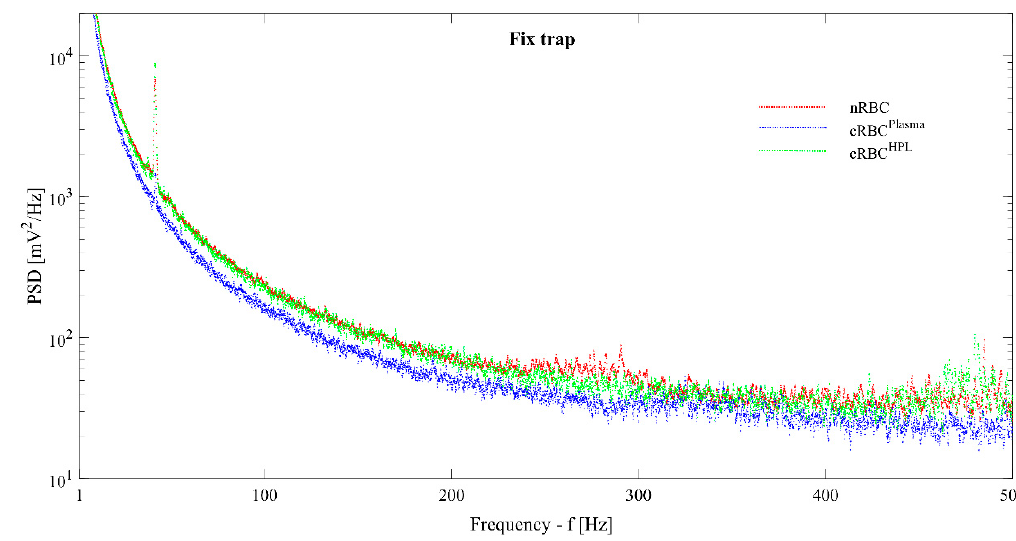
Figure 5. Power spectrum density (PSD) function calculated for fixed trap. Each PSD curve is obtained averaging over all the PSDs of the cells of the same type. The peak at the frequency f = 42 Hz is not specific to the cells; it is an artefact due to an external frequency and it can be ignored.